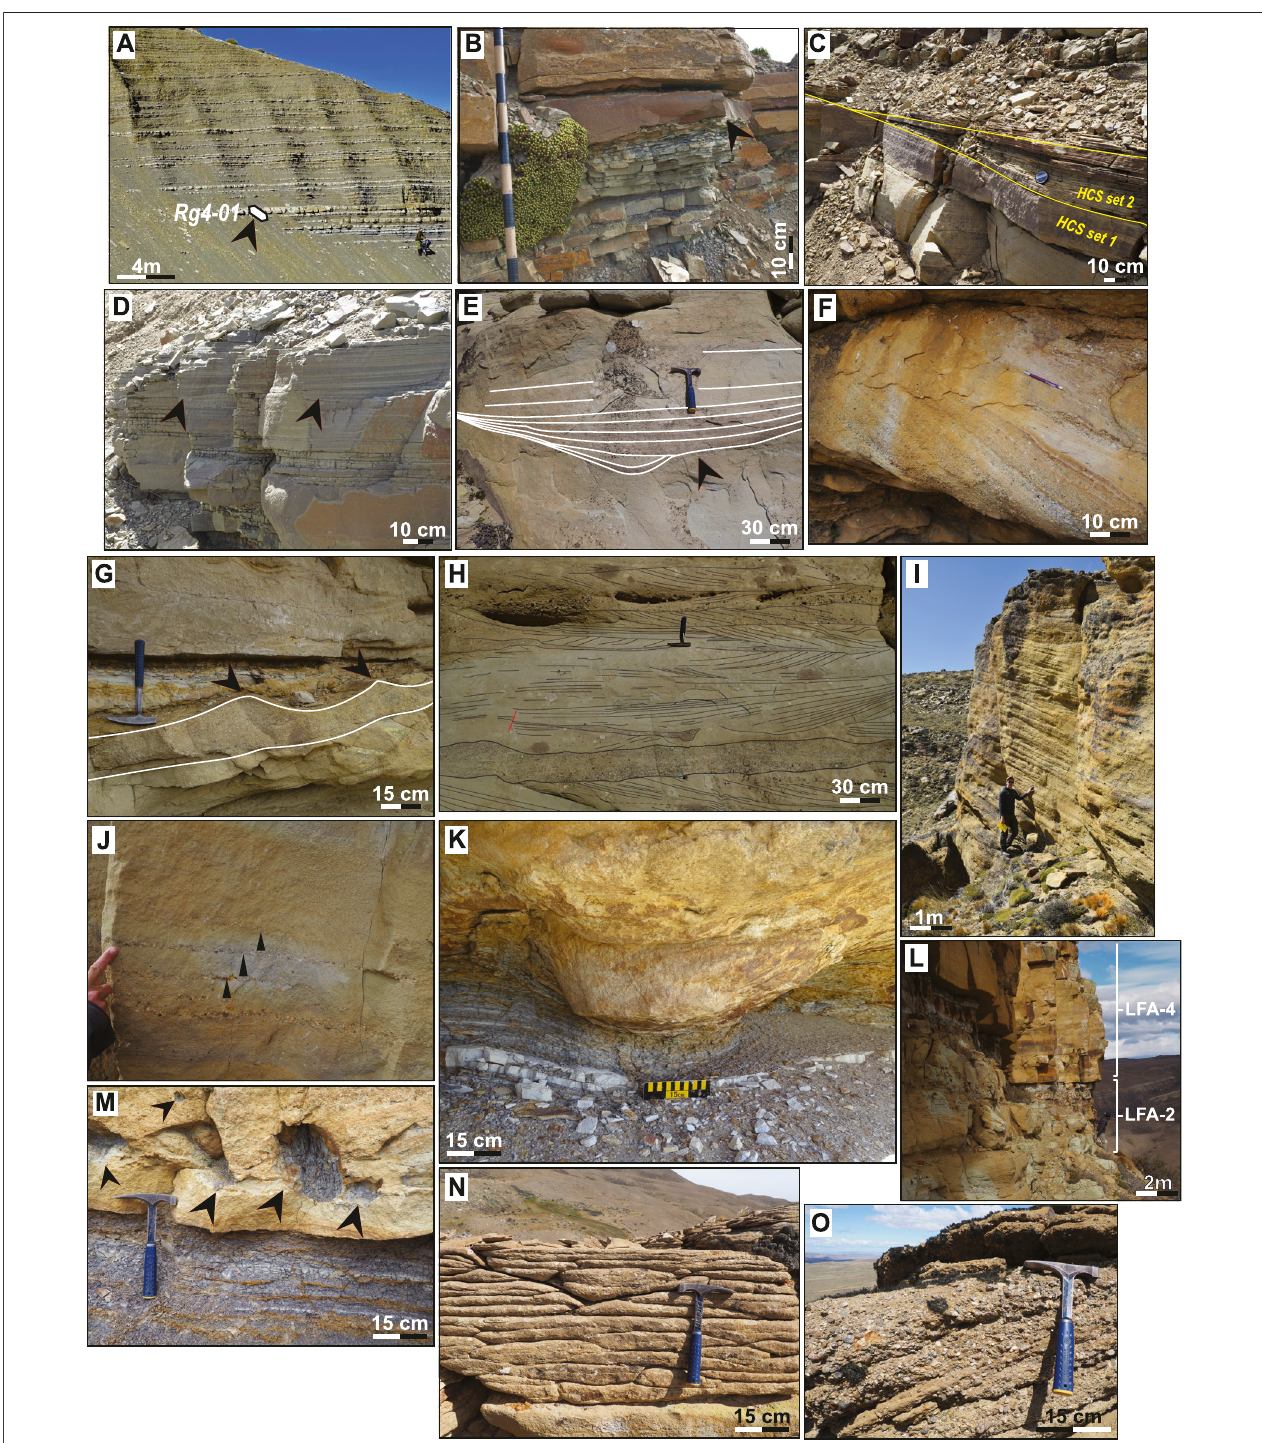
FIGURE 5| Photographsof the La Anita Formation. (A) Outcropscale example ofthe mud-rich portion ofLFA-1 and location ofsample RG4-01. (B) Bedset scale example of LFA-1 containing interstrati fi ed rippled fi ne-grained sandstone and mudstone units. Black arrow points to an erosive base of a fi ne-grained sandstone unit into fi ner grainedunits. (C) Example ofHummockycrossstrati fi cationsets fromLFA-1. Yellow linesdemarcate differentHCSbedsets. Note thelateralthinningofHCS-1 into the background of the photograph. (D) Long wavelength, undulating beds of fi ne-grained sandstone beds from section SrC. Black arrows point to a gently dippinglaminaesetpossiblyindicativeofdepositionandreworkingbystorm-generatedcurrents. (E) Exampleof fi ne-grainedsandstoneofLFA-2withgentlyundulating, longwavelengthscour fi llscomposedofupward- fl atteninglaminations. (F) Verycoarsegrainedtopebblesizedtabularcrossbeddedsandstoneandconglomeratefrom